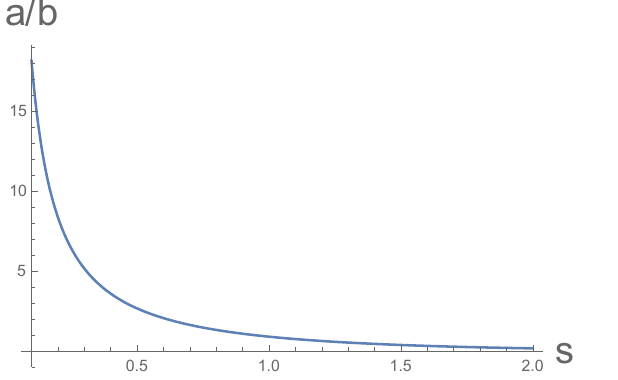
Figure 31 . The relation between s and a=b